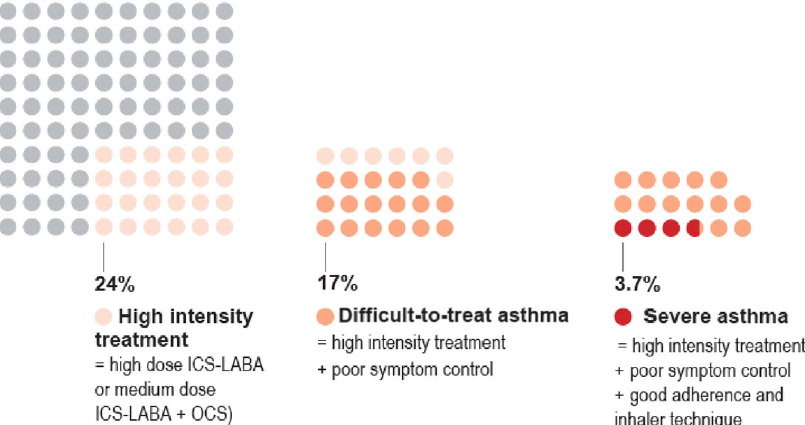
Fig. 8 Proportion of adults with dif fi cult-to-treat or severe asthma. Severe asthma is a subset of those with “ dif fi cult-to-treat ” asthma. Source: Box 3 – 15 in GINA report 2022, data from Hekking et al. 49 . Reproduced with permission from ref. 11